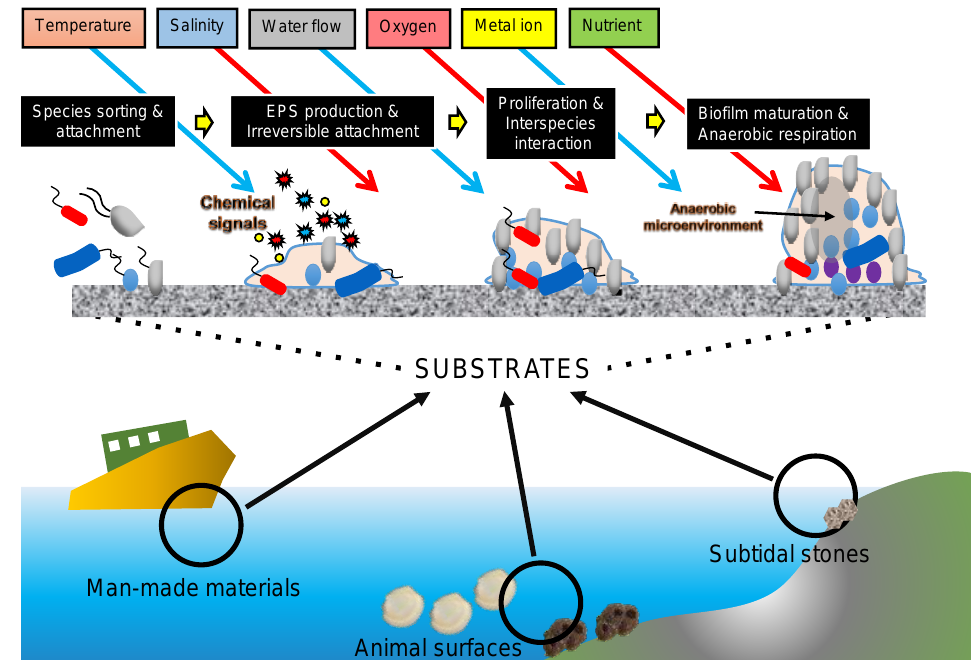
Figure 1. A schematic model of marine biofilm development.